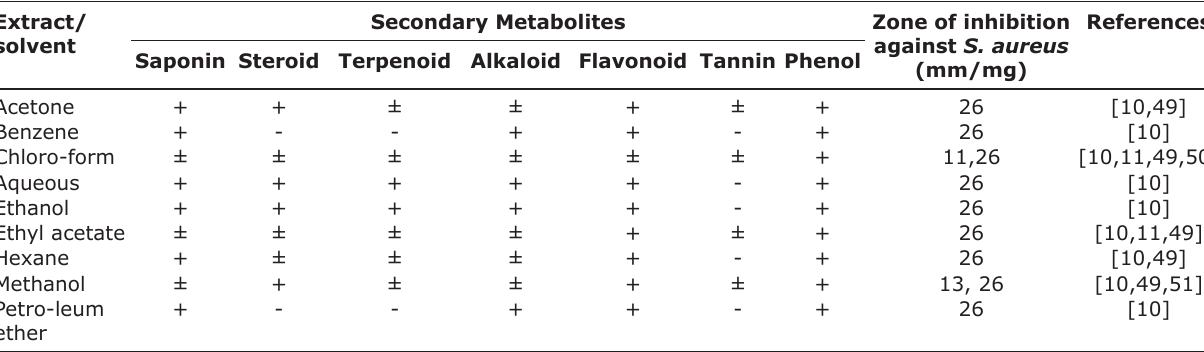
Table-4: U. lactuca extraction results based on solvents and antibacterial activity against S. aureus. Extract/